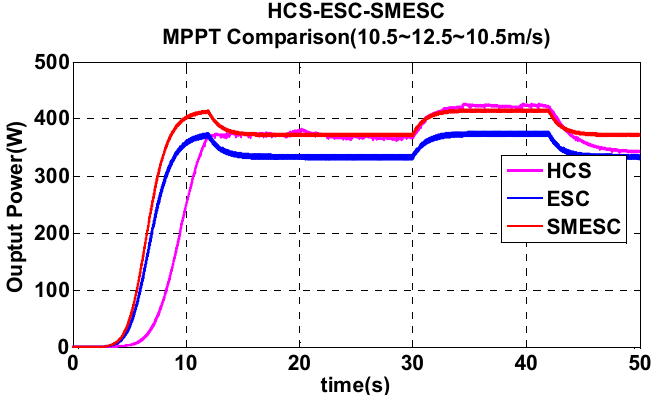
Figure 17. Output dynamic response of HCS, ESC and SMESC algorithms, respectively (variable wind speed, 10.5–12.5 m/s) .